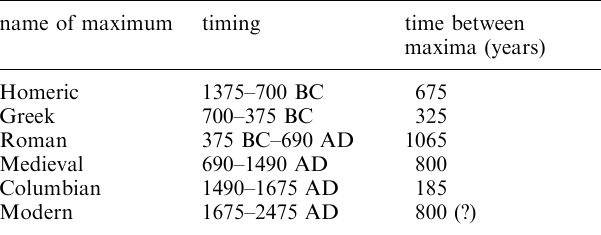
Table 1. Solar activity